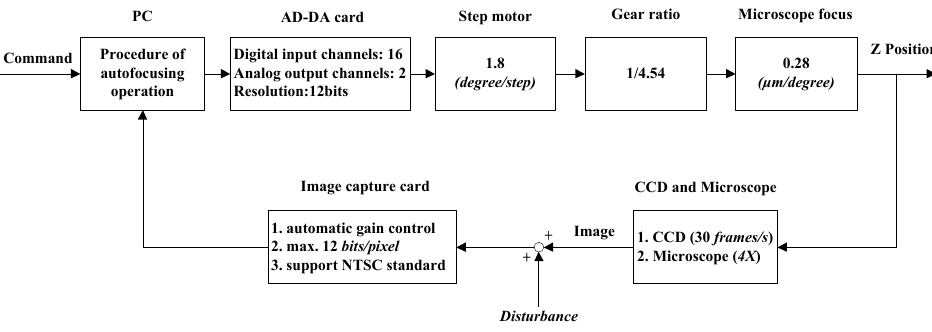
Figure 3. Block diagram of focusing control in open or closed loop through PC.